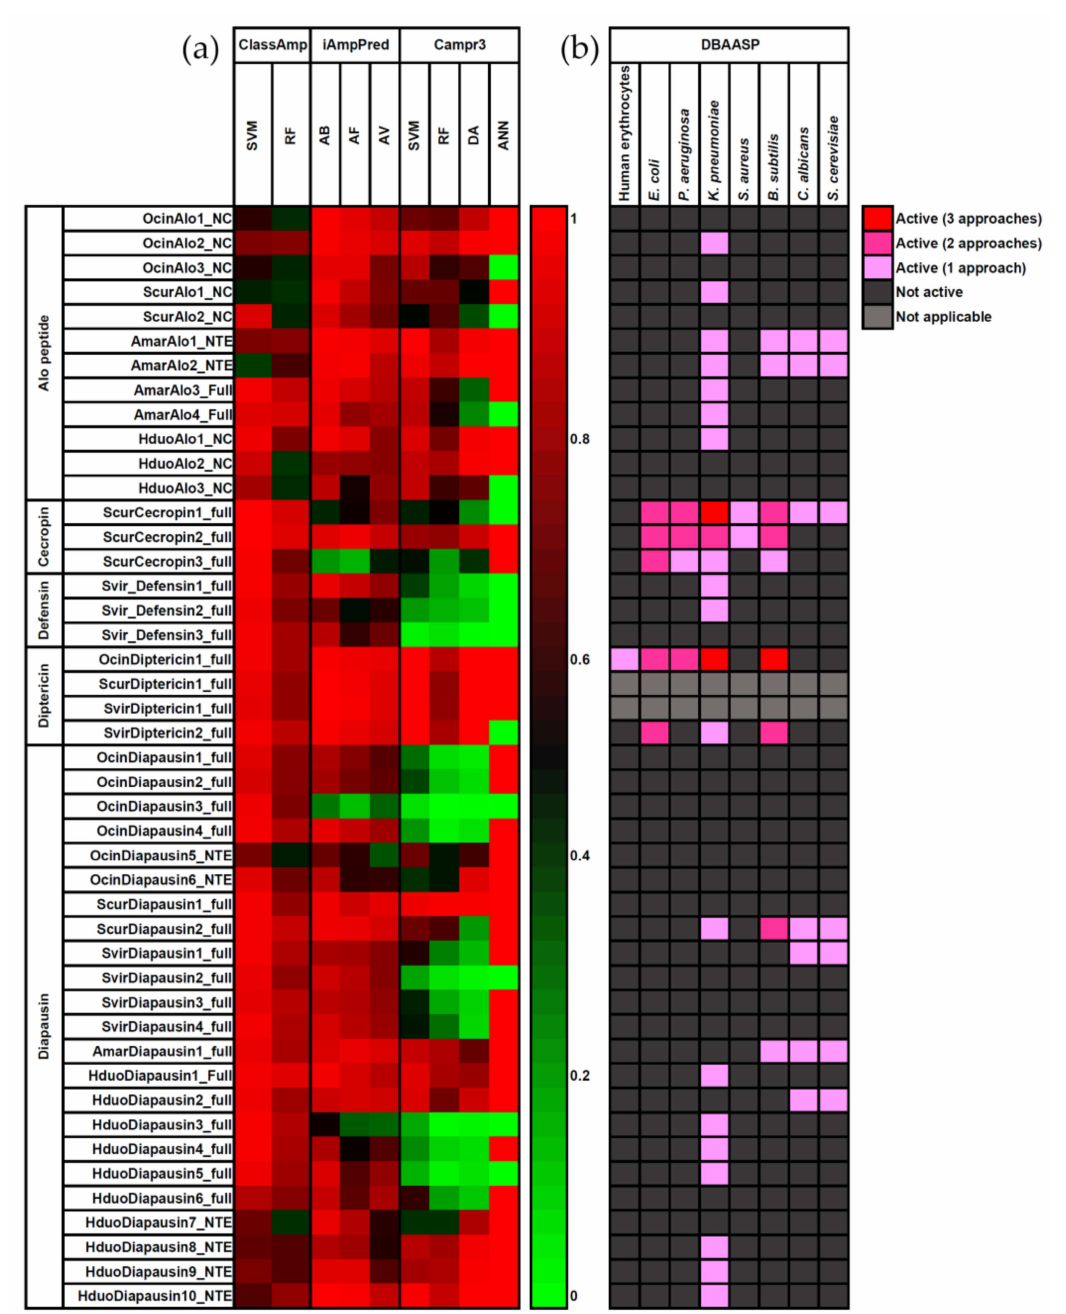
Figure 8. Prediction of antimicrobial activity: ( a ) heat map for the antimicrobial prediction of collembolan AMPs based on three programs (ClassAMP, iAmpPred, and Campr3). The probability value ranges from 0 to 1 and is indicated by the degree of color (SVM = Support Vector Machine, RF = Random Forest, ANN = Artificial Neural Network, DA = Discriminant Analysis, AB = antibacterial property, AV = antiviral property, AF = antifungal property); ( b ) hemolytic activity and strain-specific antimicrobial prediction using DBAASP, where Gram-positive bacteria include E. coli , P. aeruginosa , and K. pneumoniae ; Gram-negative bacteria include S. aureus and B. subtilis ; fungi include C. albicans and S. cerevisiae